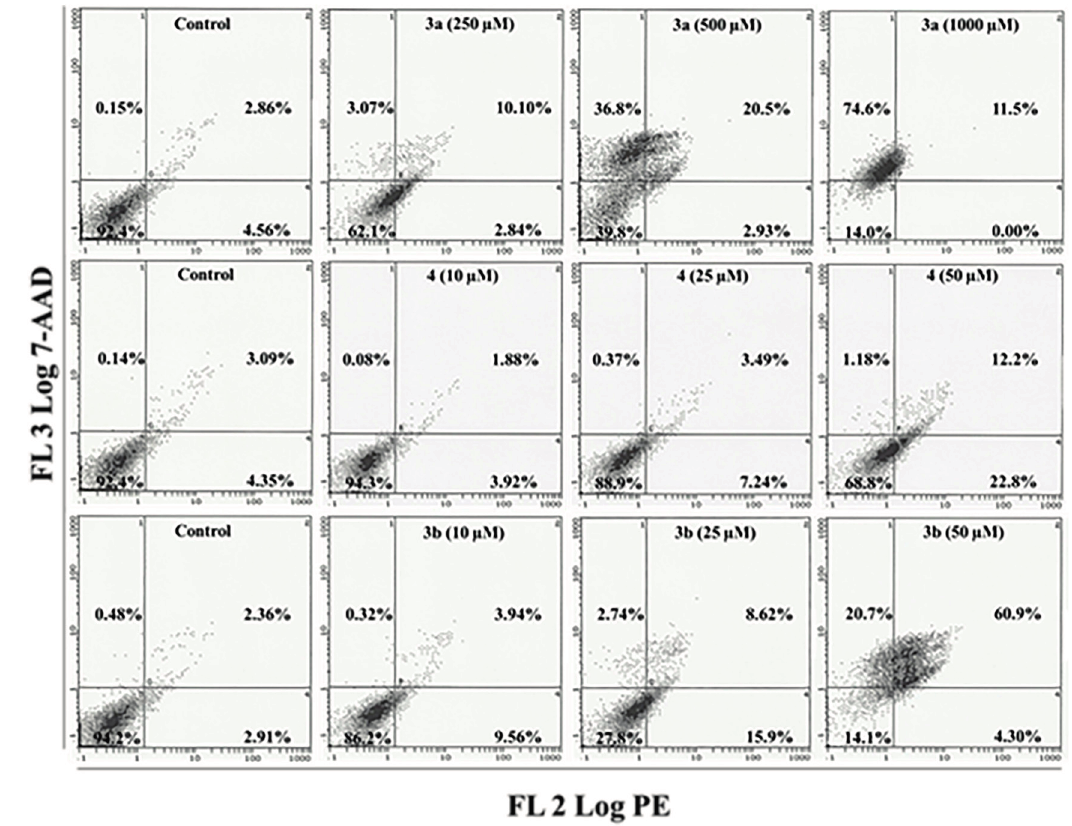
Figure 7. Annexin V-PE (phycoerythrin) and 7-AAD (7-aminoactinomycin D)